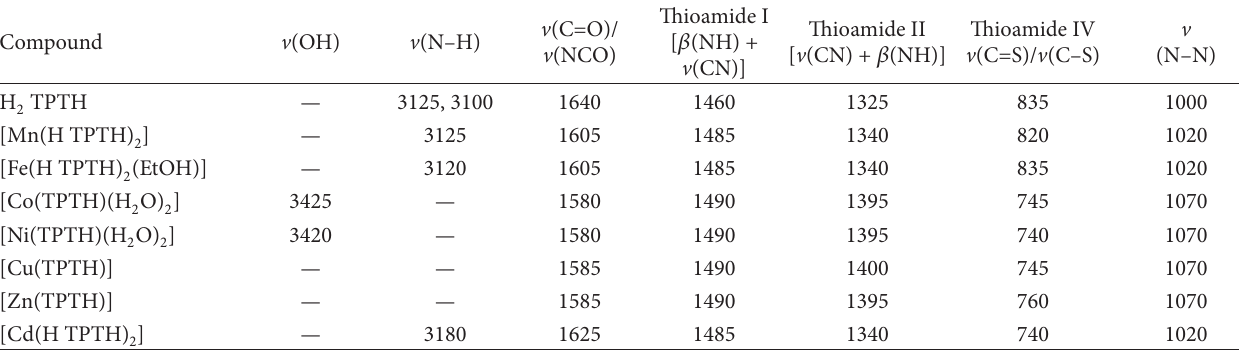
T 3: Important IR spectral bands (cm 1 ) and their assignments.